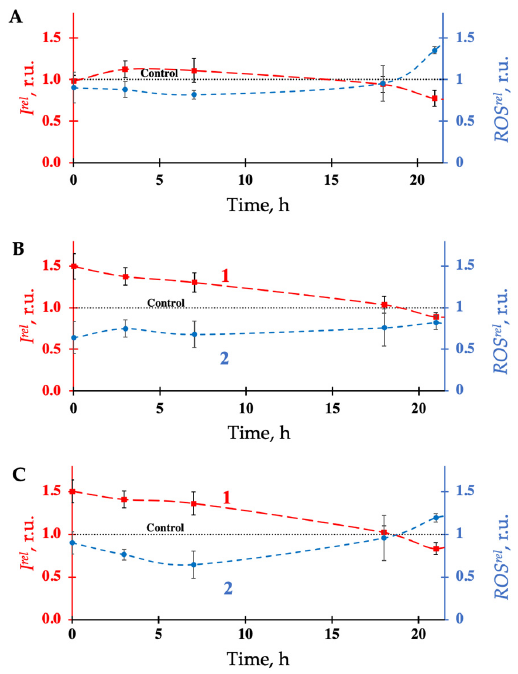
Figure 3. Kinetics of bacterial bioluminescent intensity, I rel , ( 1 ) (red color) and relative ROS content, ROS rel , ( 2 ) (blue color) in the presence of AuNPs of different concentrations: ( A )—10 − 3 g/L; ( B )—10 − 4 g/L; ( C )—10 − 5 g/L. The ROS content in the control (non-radioactive) bacterial suspension decayed from 5.9 × 10 − 6 М to 1.7 × 10 − 6 М during the duration of the experiments.